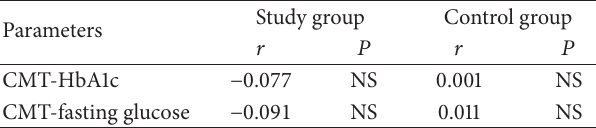
Table 3: Relationship between central macular thickness (CMT), glycosylated hemoglobin (HbA1c), and fasting blood glucose levels in patients with type 2 diabetes without clinical retinopathy. Study group Control group Parameters 𝑟 𝑃 𝑟 𝑃 CMT-HbA1c −0.077 NS 0.001 NS CMT-fasting glucose −0.091 NS 0.011 NS CMT: central macular thickness, HbA1c: glycosylated hemoglobin, 𝑃 : statis- tic value, and 𝑟 : relation between two variables. NS: nonsignificant, study group: patients with type 2 diabetes without clinical retinopathy, and control group: healthy